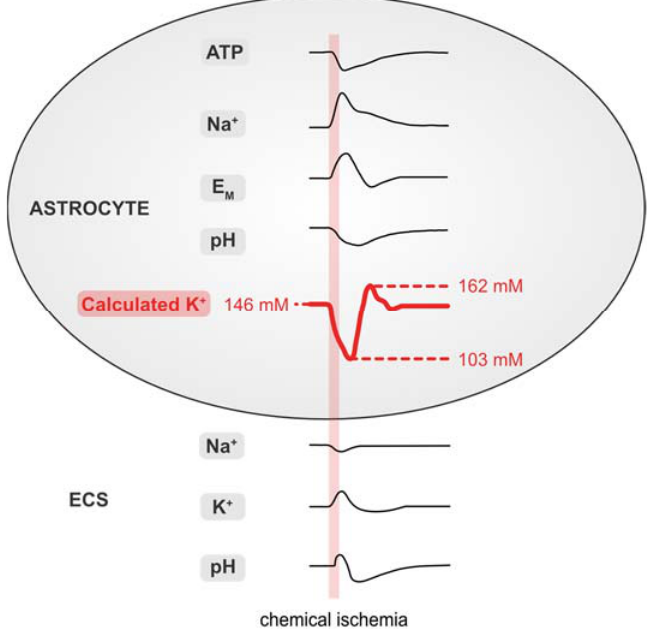
Figure 7. Summary of results. Schematized changes in extra ‐ and intracellular ion concentrations upon chemical ischemia for 2 min. Values for [K + ] i were approximated from experimental traces using the GHK equation. ECS: extracellular space. Table 1. Extra ‐ and intracellular changes induced by chemical ischemia for 2 min.